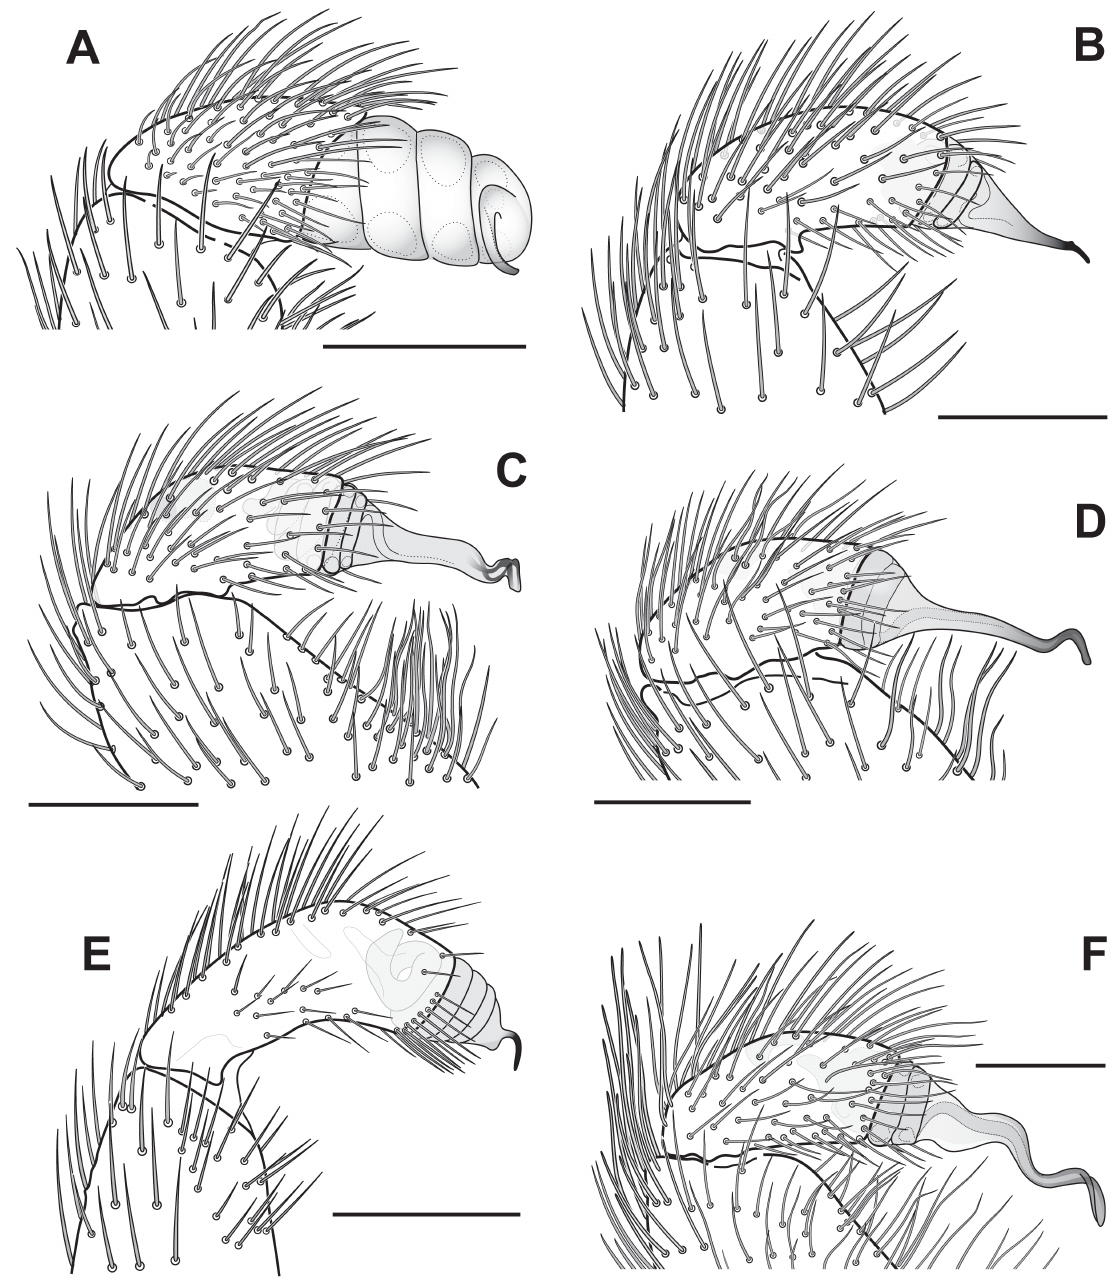
Fig. 43. Male copulatory organs of Zaitunia species, retrolateral. A . Z. schmitzi (Kulczyński, 1911) (Jerusalem area). B . Z. annulipes (Kulczyński, 1908) (Paramali). C . Z. kunti sp. nov. (holotype). D . Z. minoica sp. nov. (paratype). E . Z. logunovi sp. nov. (paratype). F . Z. martynovae (andreeva & Tyshchenko, 1969) (Gandzhina). Scale bars = 0.2